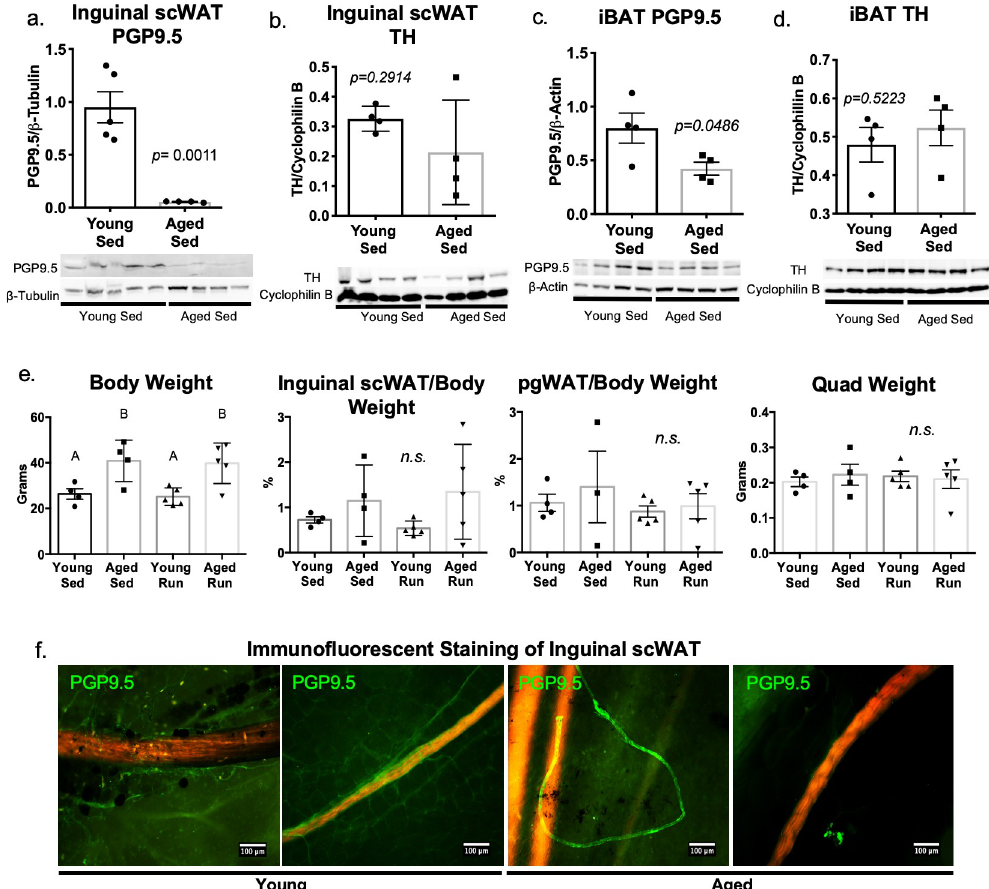
Fig 4. Aging is associated with adipose tissue neuropathy. In young (10–12 weeks old) and aged (16 months old) sedentary male C57BL/6J mice, western blotting was used to measure protein expression of PGP9.5 in inguinal scWAT for assessment of total innervation (a) while TH was used to assess sympathetic activation (b). In the same animals, protein expression of PGP9.5 (c) and TH (d) in intrascapular brown adipose tissue (iBAT) was measured by western blot. Protein expression was normalized to either β -Actin, β -Tubulin or Cycophilin B, band intensity was quantified in Image J and analyzed by two-tailed Student’s t-test; N = 4 for young and aged groups. Body weight, adiposity (inguinal scWAT/body weight & pgWAT/body weight), and quadricep muscle weight was measured for young (12 weeks old) and aged (16 month old) mice under sedentary (sed) and exercised (run) conditions (e). Body and tissue weight analyzed by one-way ANOVA, with Tukey post hoc, groups labeled with the same letter (A or B) are statistically similar, for body weight: p = 0 . 0473 for young sed v. aged sed; p = 0 .0240 for young run v aged run. For young and aged sedentary animals N = 4, for young and aged exercised (run) mice, N = 5 per group. Whole depot immunofluorescent imaging of inguinal scWAT from sedentary animals for total innervation (PGP9.5 in green) and vasculature (red/orange; autofluorescence) was performed (f). Images captured at 10x on Nikon Eclipse E400 microscope and are representative of N = 4 mice analyzed per group. Error bars are SEMs, � p < 0.05, �� p < 0.01, ��� p < 0.001, ���� p <